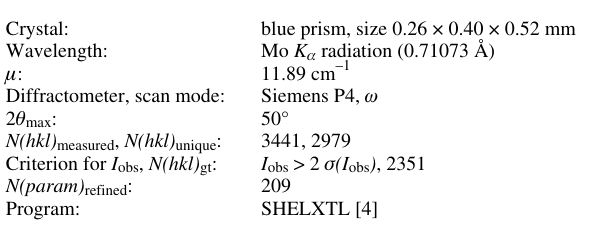
Table 1. Data collection and handling.